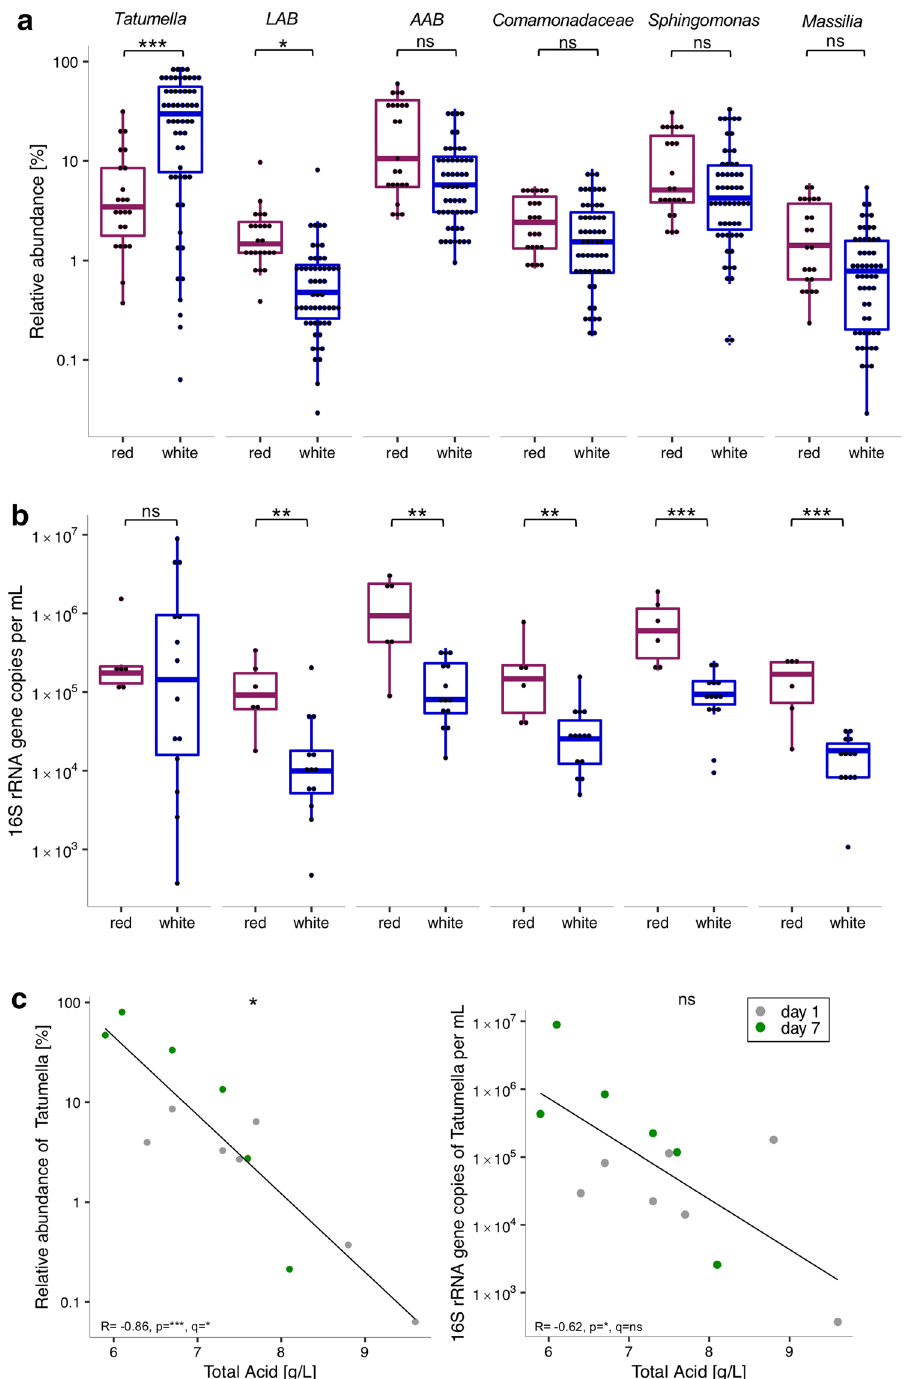
Figure 2. Bacterial groups with differential relative ( a ) and absolute ( b ) abundance in red and white wines and association with total acid content in wine ( c ). The relative abundances, based on 16S rRNA gene amplicon sequencing ( a ) and absolute abundances, based on 16S rRNA gene copy number concentrations ( b ) in red and white wines were compared for the proteobacterial genus Tatumella , lactic acid bacteria (LAB), acetic acid bacteria (AAB) and the proteobacterial family Comamonadaceae and genera Sphingomonas and Massilia . Relative and absolute abundance of Tatumella and total acid content (g/L) were negatively correlated, based on available metadata ( c ). Significance was calculated based on ALDEx analysis with 128 DMCs ( a , b ) and Spearman’s rank correlation test ( c ), all corrected with the Benjamini–Hochberg procedure, with ns = not significant, *p/q < 0.05, **p/q < 0.01, ***p/q < 0.001. Effect sizes for ALDEx analyses in ( a ): Tatumella = 0.87, LAB = − 0.47, AAB = − 0.14, Comamonadaceae = 0.21 Sphingomonas = 0.21, Massilia = −